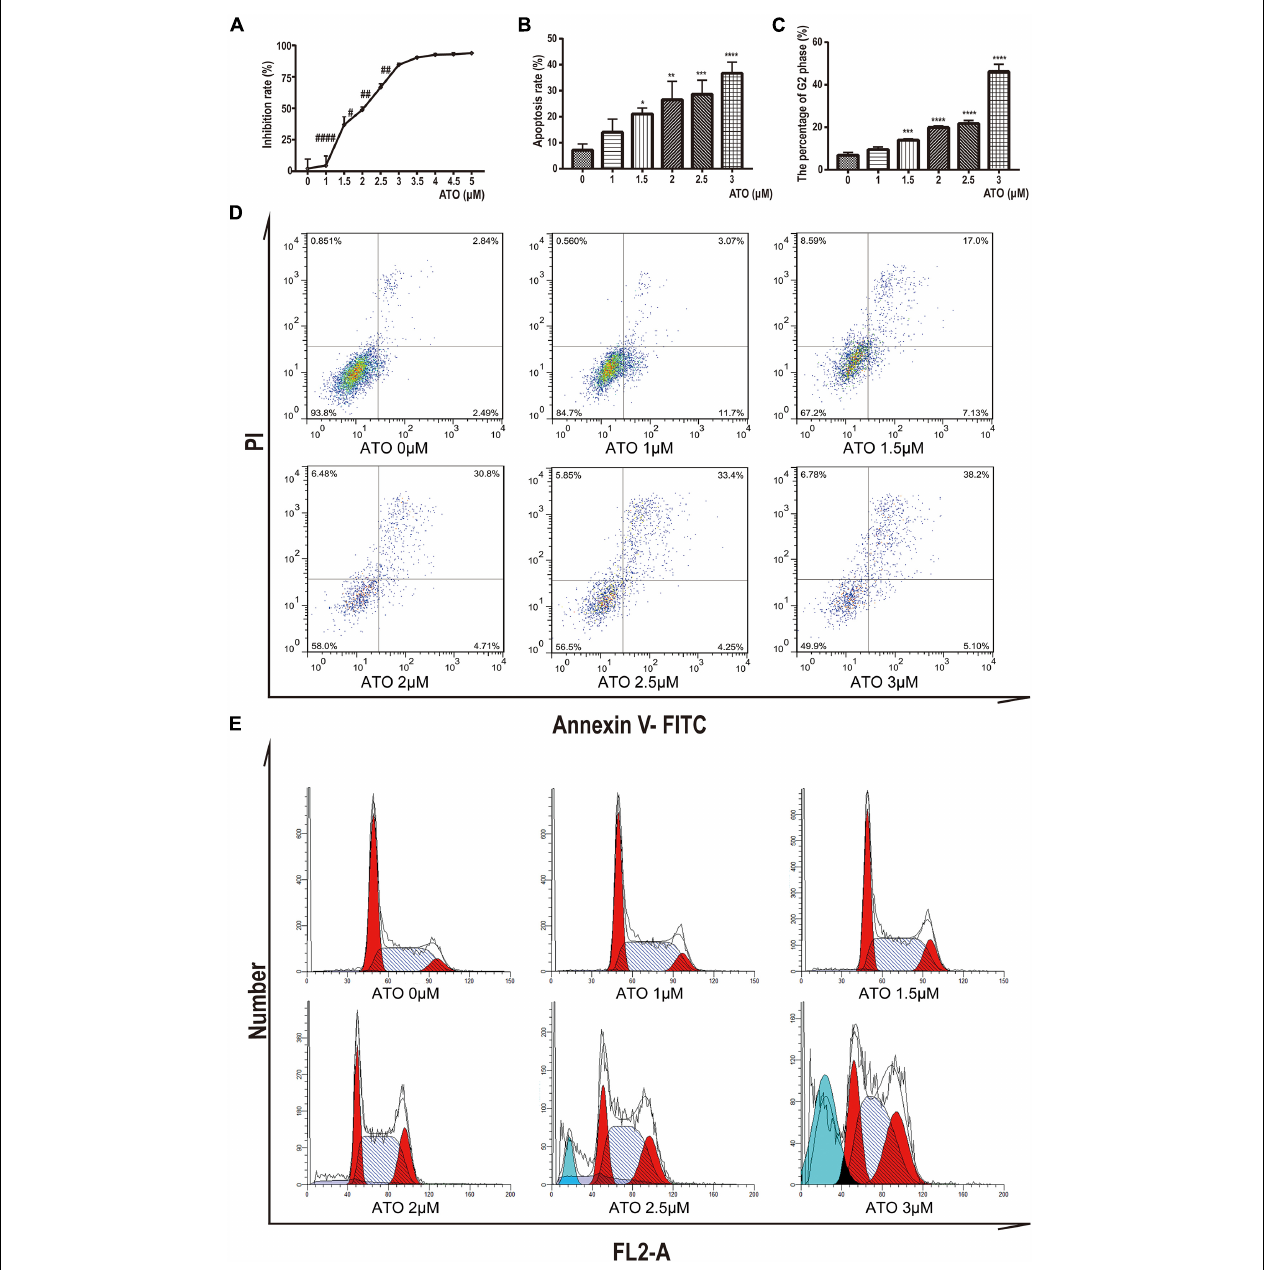
FIGURE 1 | Effects of ATO treatment on proliferation, apoptosis, and cell cycle in KG1a cells. (A) Effects of ATO treatment on proliferation in KG1a cells. Cell proliferation was determined using Cell Counting Kit-8 assays, and the cell inhibition rate is shown. Data are shown as means ± SD of three independent experiments. # p < 0.05, ## p < 0.01, #### p < 0.0001 ATO versus ATO. (B , D) Effects of ATO treatment on apoptosis in KG1a cells. KG1a cells treated with ATO were analyzed by flow cytometry following annexin V/PI staining; representative scatterplots of KG1a cells treated with ATO are shown (B) . The data are expressed as the percentage of cells in annexin V + /PI - and annexin V + /PI + (D) . Data are shown as means ± SD of three independent experiments. * p < 0.05, ** p < 0.01, *** p < 0.001, **** p < 0.0001, ATO versus control. (C , E) Effects of ATO treatment on cell cycle progression in KG1a cells. Flow cytometric analysis of the cell cycle following PI staining; representative histograms of KG1a cells treated with ATO are shown (C) . The data are expressed as the percentage of cells in the G2 phase of the cell cycle (E) . Data are shown as means ± SD of three independent experiments. *** p < 0.001, **** p < 0.0001, ATO versus